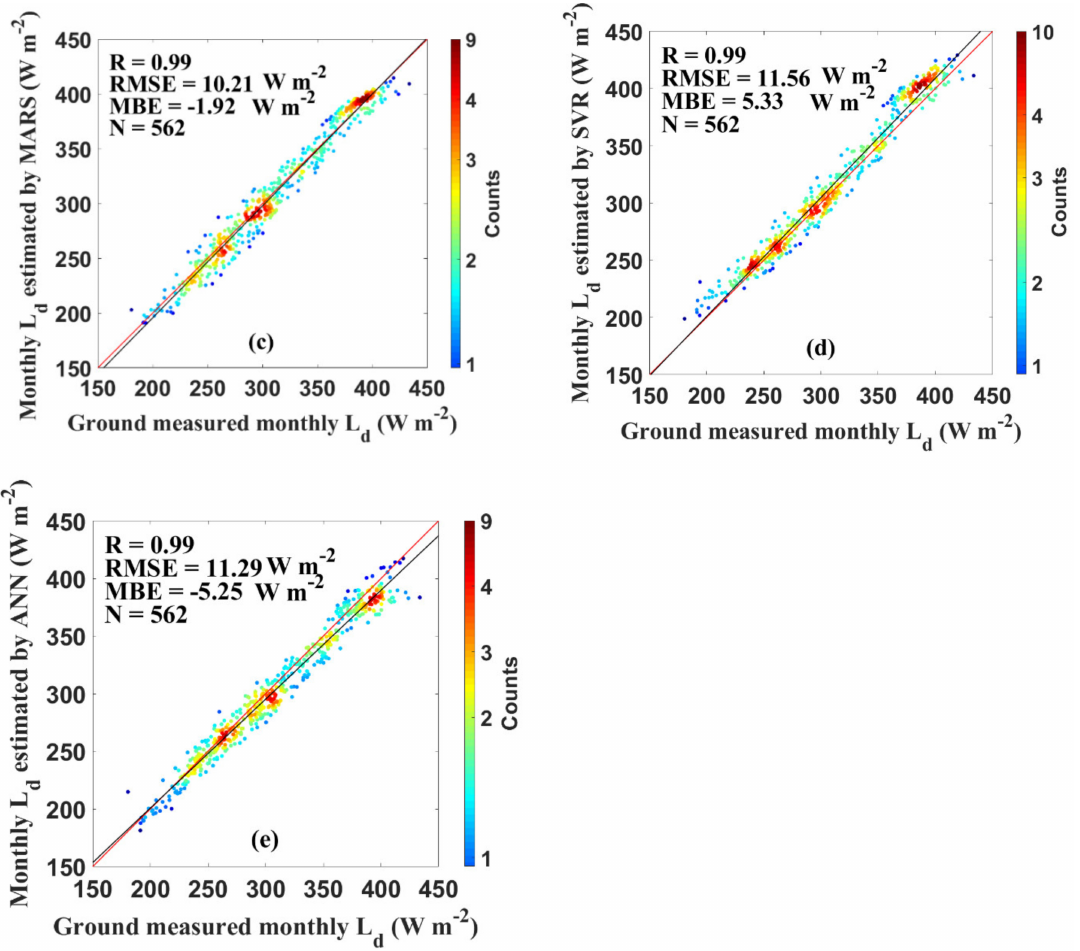
Figure 5. Evaluation results of the monthly L d estimates on the basis of the ( a ) GBRT, ( b ) RF, ( c ) MARS, ( d ) SVR, and ( e ) ANN methods against the ground measurements on the test dataset. N is the number of data records. The red and black lines represent the 1:1 and fitted lines,